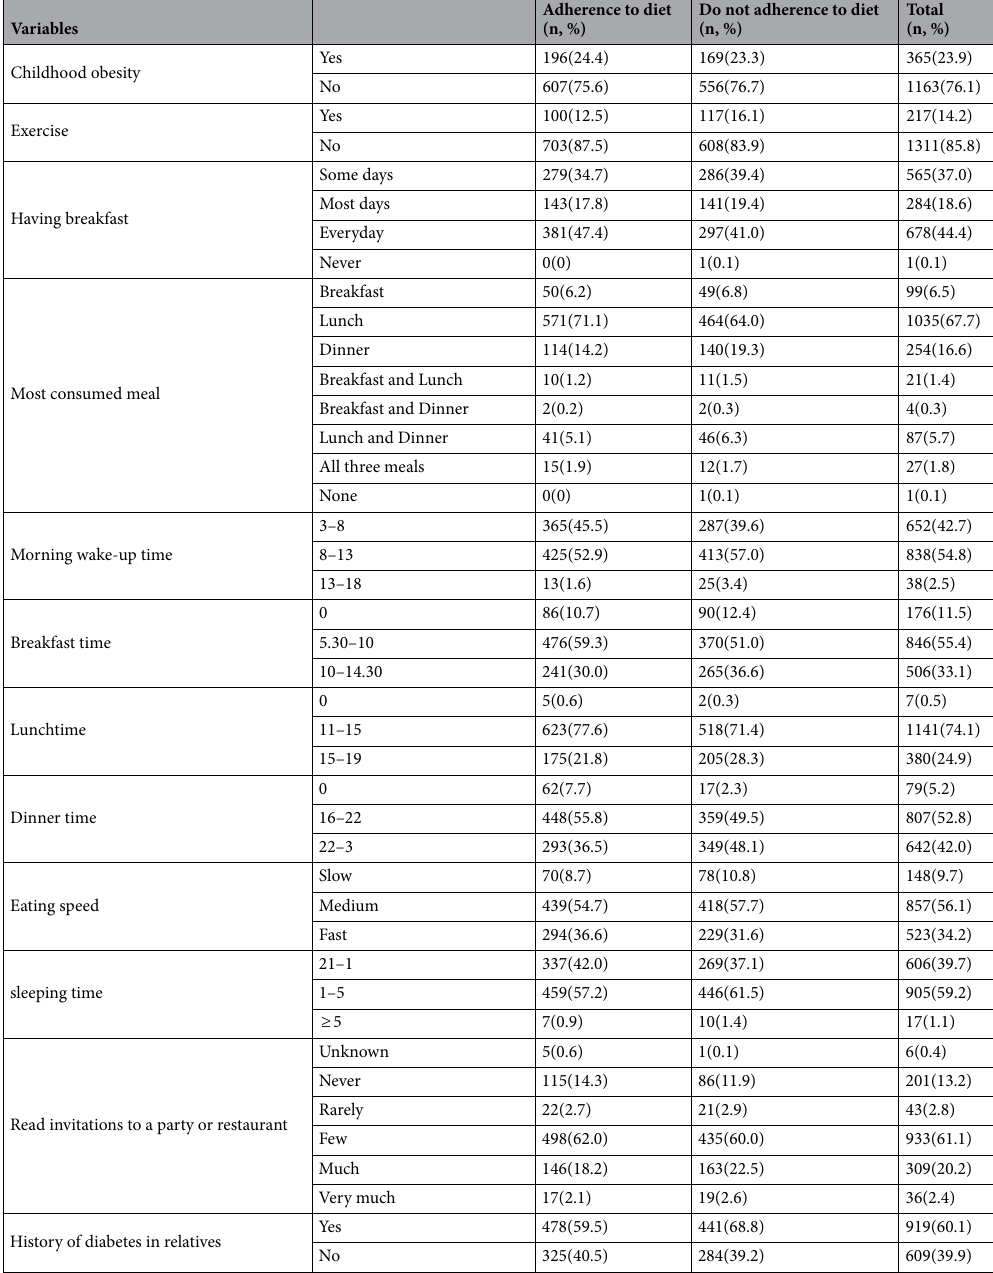
Table 1. Basic characteristics of the prediction of continuity in referral to nutrition for diet follow-up Data presented by (number